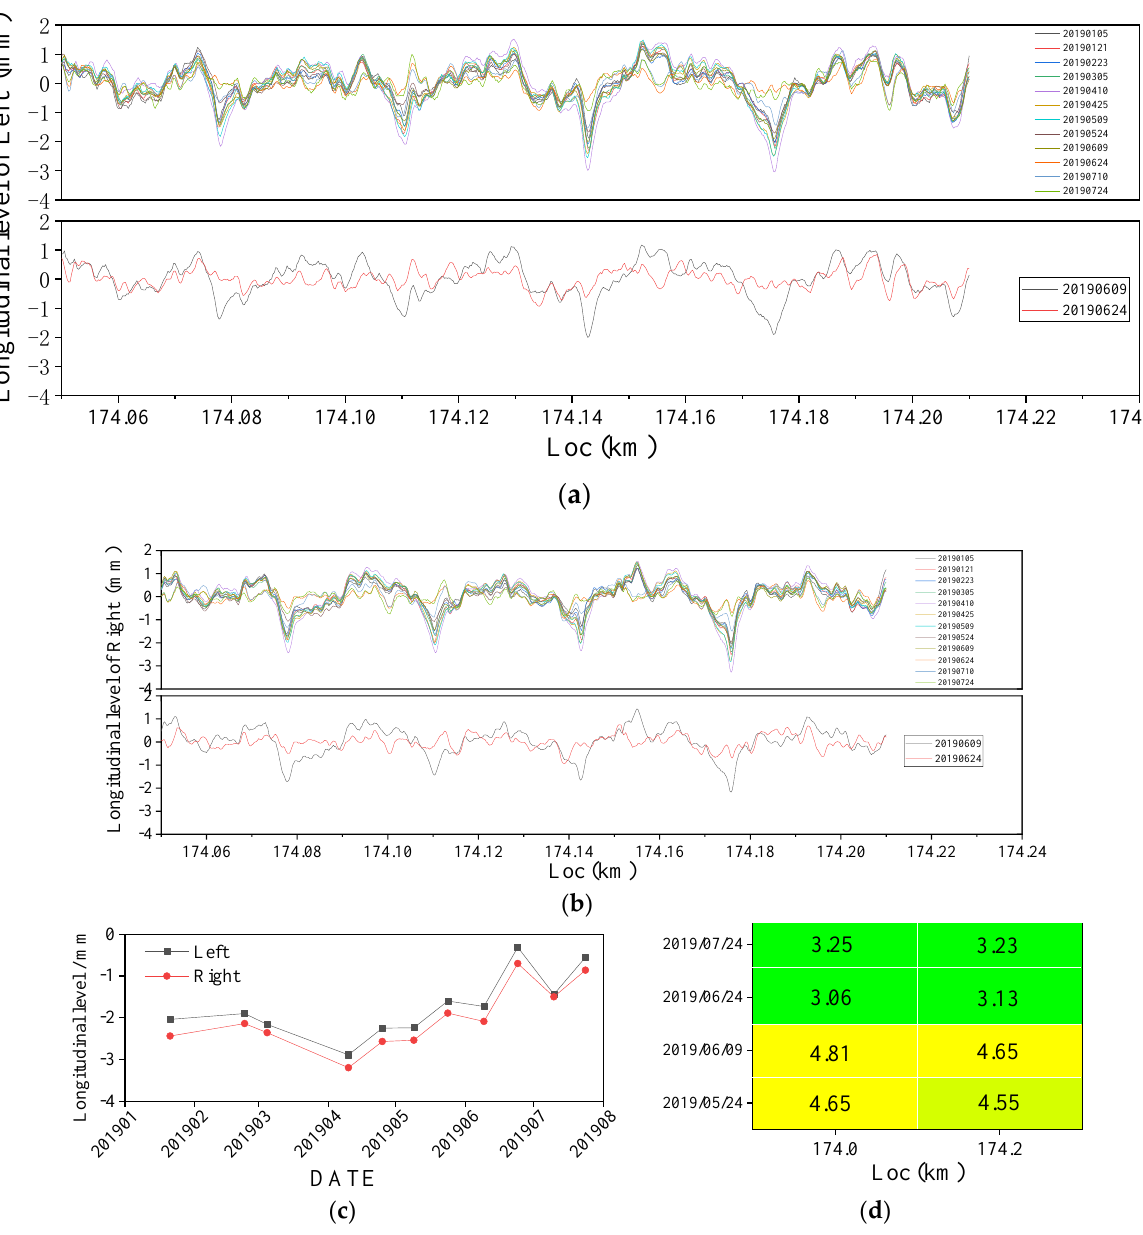
Figure 28. Track longitudinal level and the amplitude at the beam joint. ( a ) Track longitudinal level of left. ( b ) Track longitudinal level of right. ( c ) Longitudinal level at the location of 174.175 km. ( d ) TQI from 174.000 km to 174.400 km.